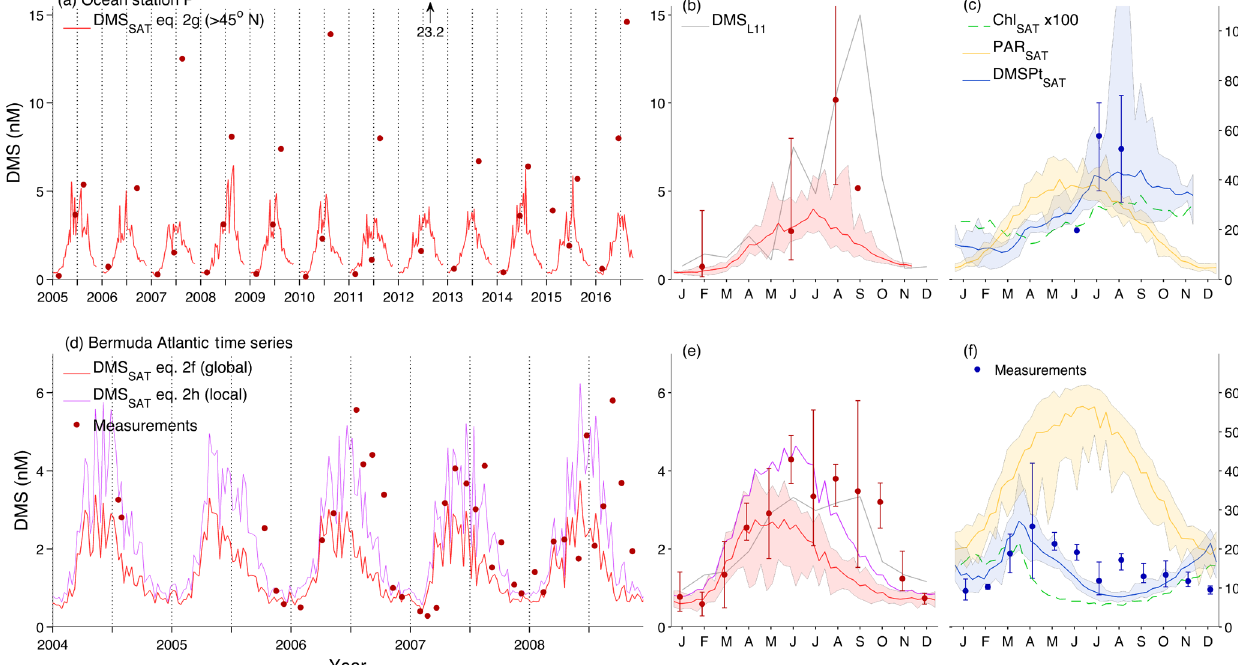
Figure 9. DMS SAT vs. in situ data at long-term research stations. (a–c) Ocean Station P in the northeast Pacific (50 ◦ N, 145 ◦ W); (d– f) BATS station (31 ◦ 40 (cid:48) N, 64 ◦ 10 (cid:48) W). (a, d) compare DMS SAT estimates to in situ measurements; (b, e) compare monthly DMS means (i.e., climatologies) derived from DMS SAT (2003–2016 MODIS-Aqua data), in situ data (available measurements between 2003–2016) and the L11 climatology; (c, f) show the corresponding Chl SAT , DMSPt SAT and PAR SAT climatologies (2003–2016) and in situ DMSPt. Lines and shaded envelopes show the mean ± range of satellite-derived data; filled circles and error bars show the mean ± range of available in situ data. DMS and DMSPt are in nM units, Chl in µgL − 1 and PAR in mol photonsm − 2 d − 1 . In addition to public OSP data (three DMS measurements per year generally available between 2005 and 2016) we show DMSPt data reported in published studies (Asher et al., 2017; Levasseur et al., 2006; Royer et al., 2010). BATS data are comprised of the monthly 2005–2008 time series (Levine et al., 2016) and cruise data from the vicinity of BATS station in July 2004 (Bailey et al., 2008; Gabric et al.,